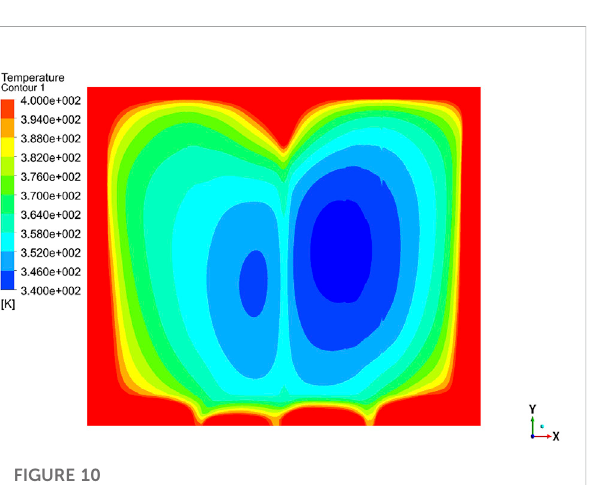
FIGURE 10 Instantaneous temperature distribution of Plane 3 at 2,400